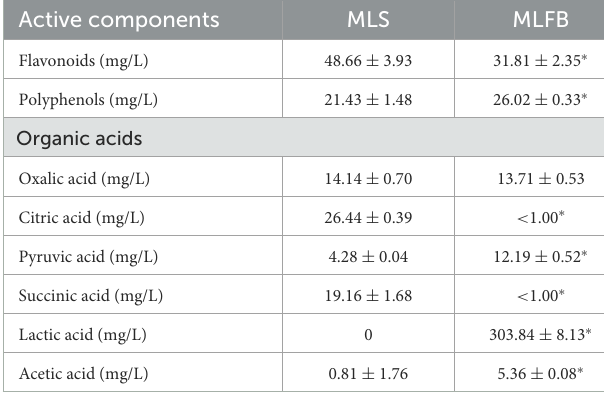
TABLE 2 The key active components changes in MLFB after